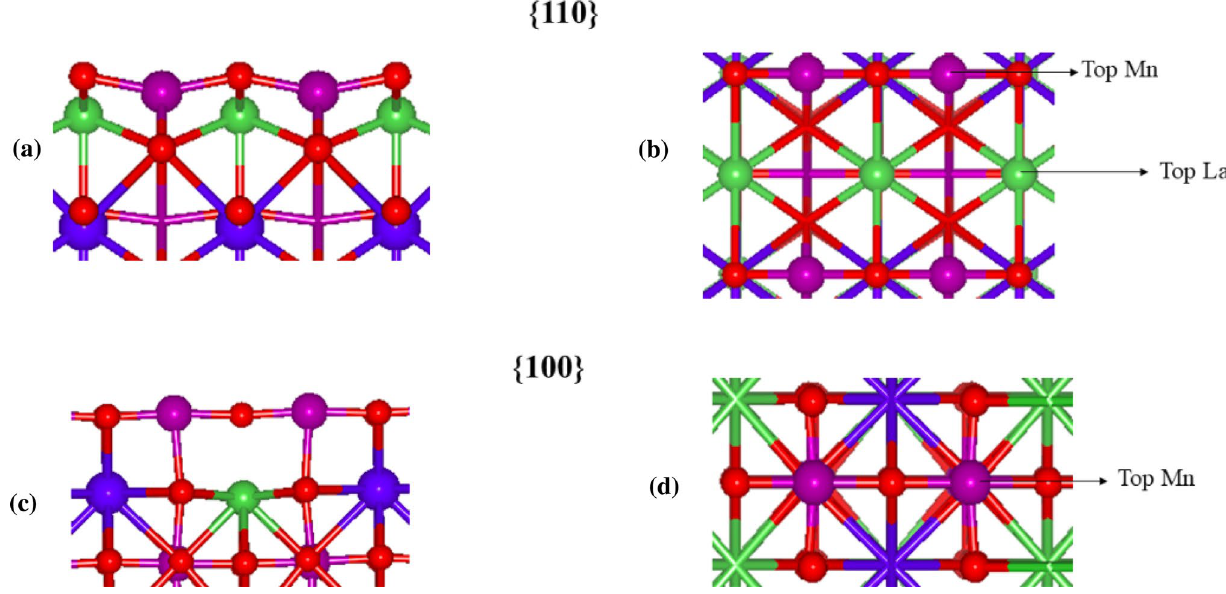
Fig. 2 Schematic representation of the side and top views of the (2 × 1) slab model of ( a , b ) LBM25 {110} and ( c , d ) LBM25 {100} supercells showing the corresponding different adsorption sites explored. Color code: green = La, blue = Ba, purple = Mn, and red =